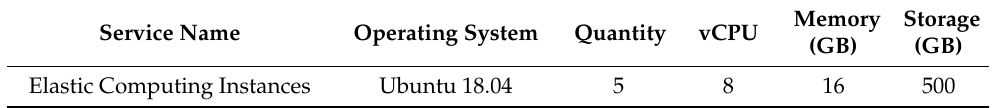
Table 9. Cloud resource list for Pattern III.